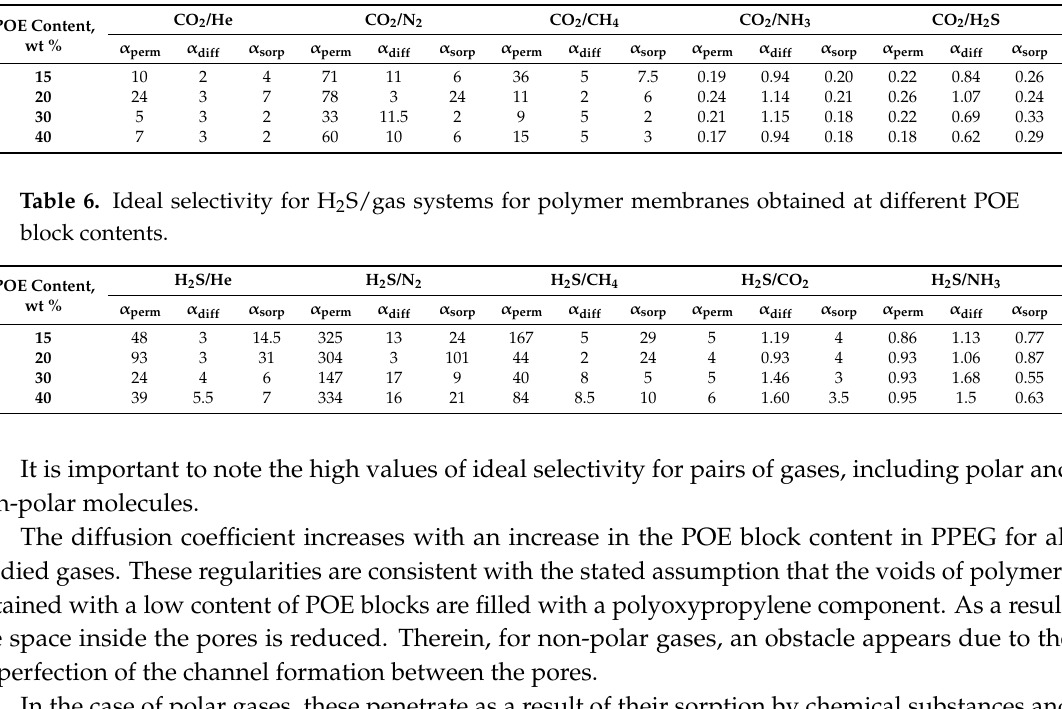
Table 5. Ideal selectivity for CO 2 /gas systems for polymer membranes obtained at different POE block contents.